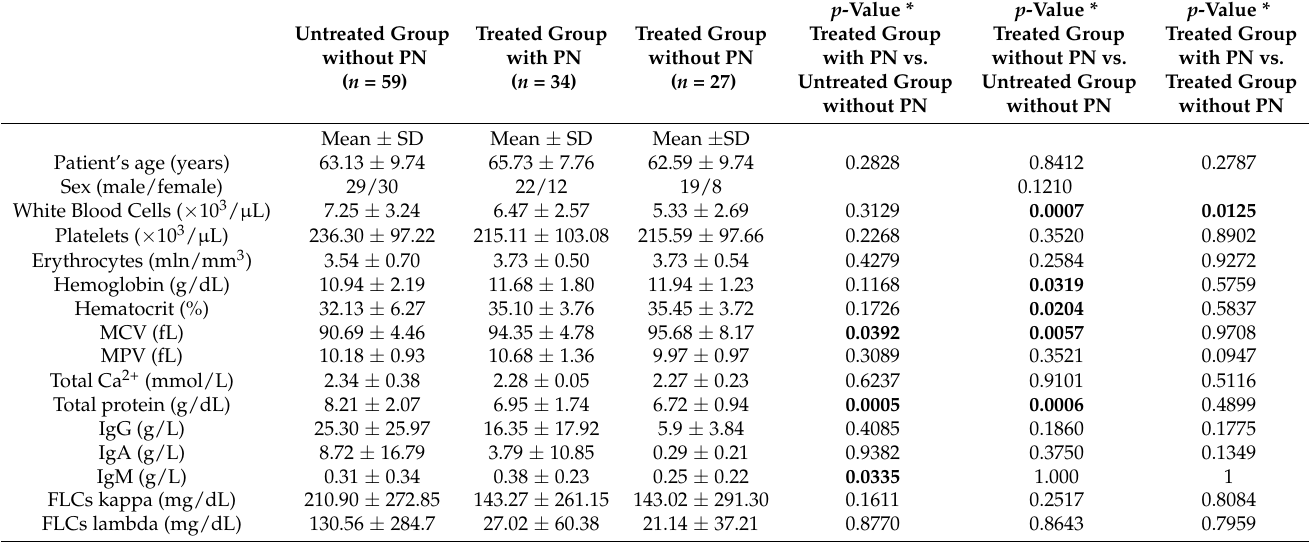
Table 1. Clinical characteristics of the study